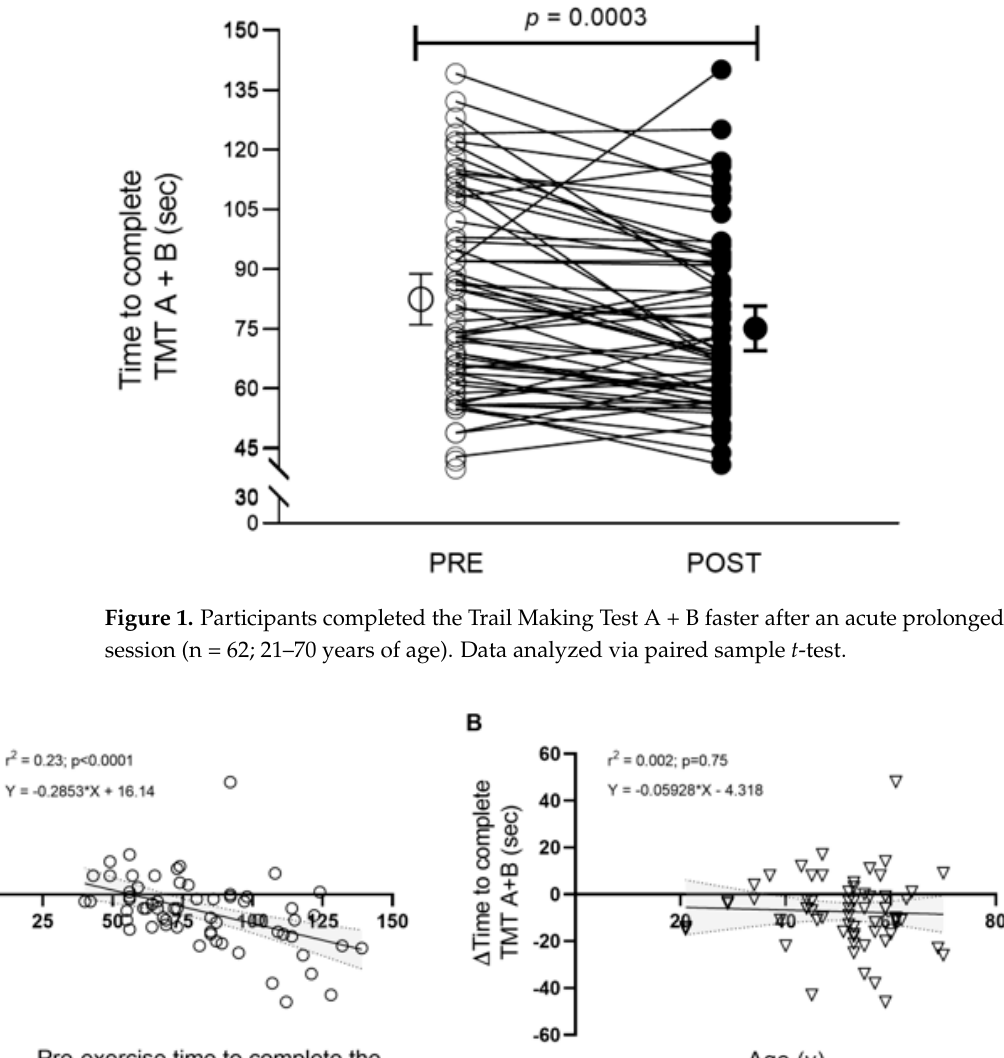
Figure 2. Baseline Trail Making Test A + B performance (n = 62) accounted for 23% of the variance in the magnitude of change following the prolonged exercise bout. Linear regression analysis of the association between the change in time to complete the TMT A + B (post vs. pre) ( ∆ TMT A + B; independent variable) with ( A ) pre-exercise time to complete the Trail Making Test Part A + B and ( B )